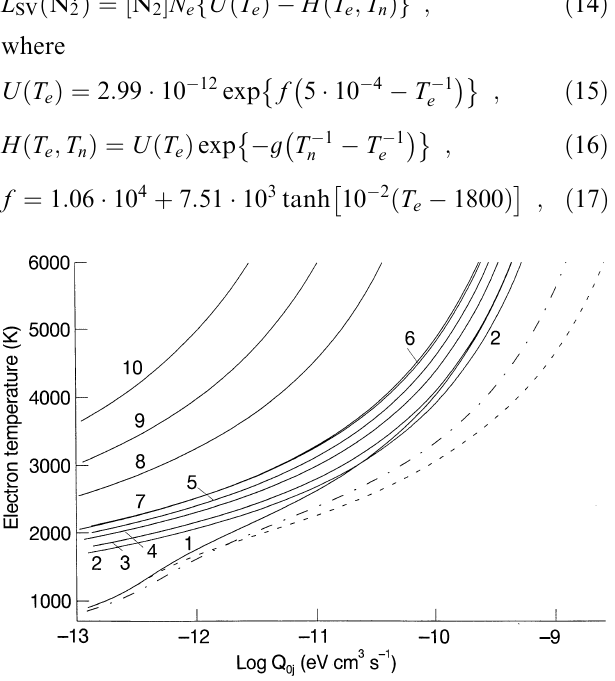
Fig. 1. The calculated Q 0 v for the N 2 vibrational levels v (cid:136) 1–10 ( solid curves 1–10). The dashed line is of this paper, and the dashed-dotted line is U (cid:133) T e (cid:134) given by Eq. (12) of Stubbe and Varnum (1972)